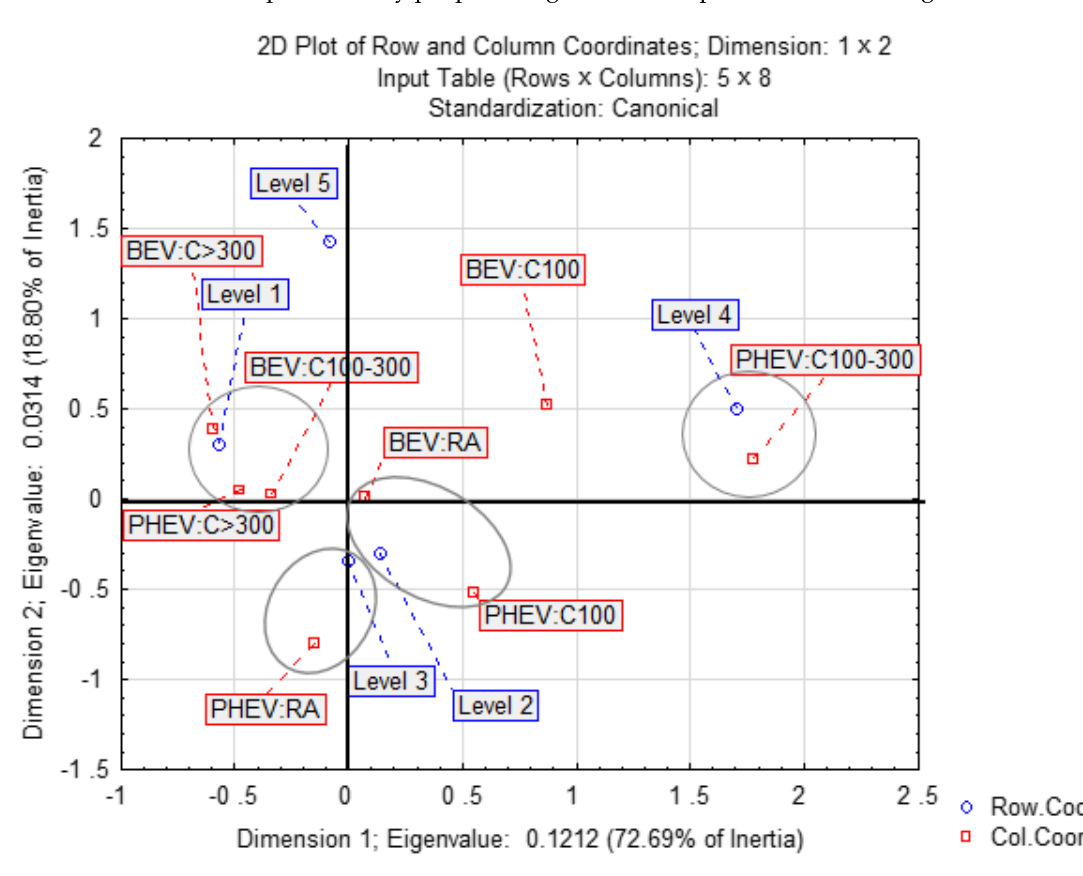
Figure 2. Correspondence analysis results between two groups of characteristics: autonomy level, type of car and places of living, standardization canonical. Where: Level 1— driver’s assistant , Level 2— partial automation , Level 3— conditional automation , Level 4– high automation , Level 5— full automation , RA—rural areas, C100 — city with up to 100,000 residents, C100-300 — city with 100,000–300,000 residents, C > 300 — city with more than 300,000 residents.